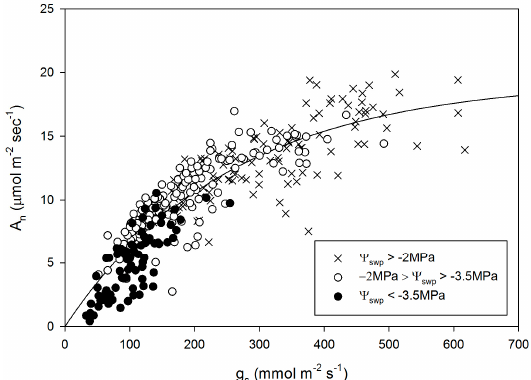
Figure 3. Relationship between net photosynthesis (A n , μ mol m − 2 s − 1 ) and stomatal conductance (g s mmol m − 2 s − 1 )). The best fit relationship, for the entire data pool, was obtained using an exponential function: y = 19.4 × (1 − e ( − 0.0039 x ) ); r 2 = 0.80; p < 0.0001.